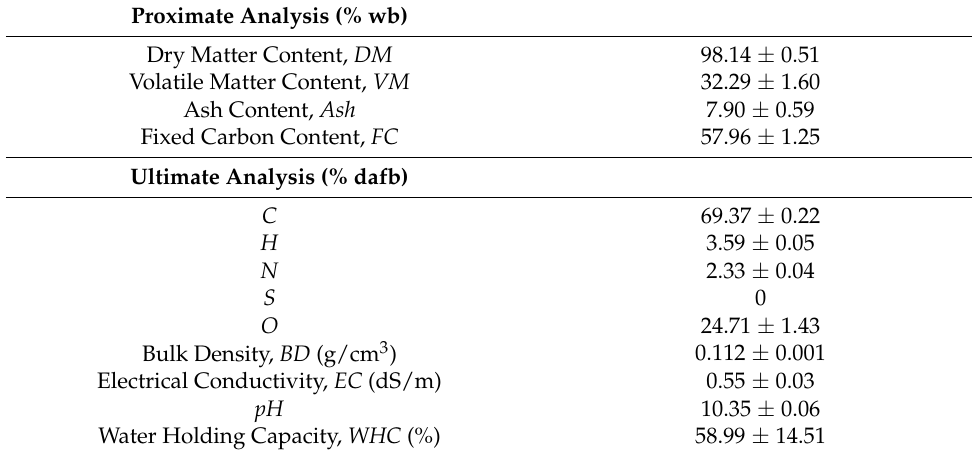
Table 2. Physicochemical properties of